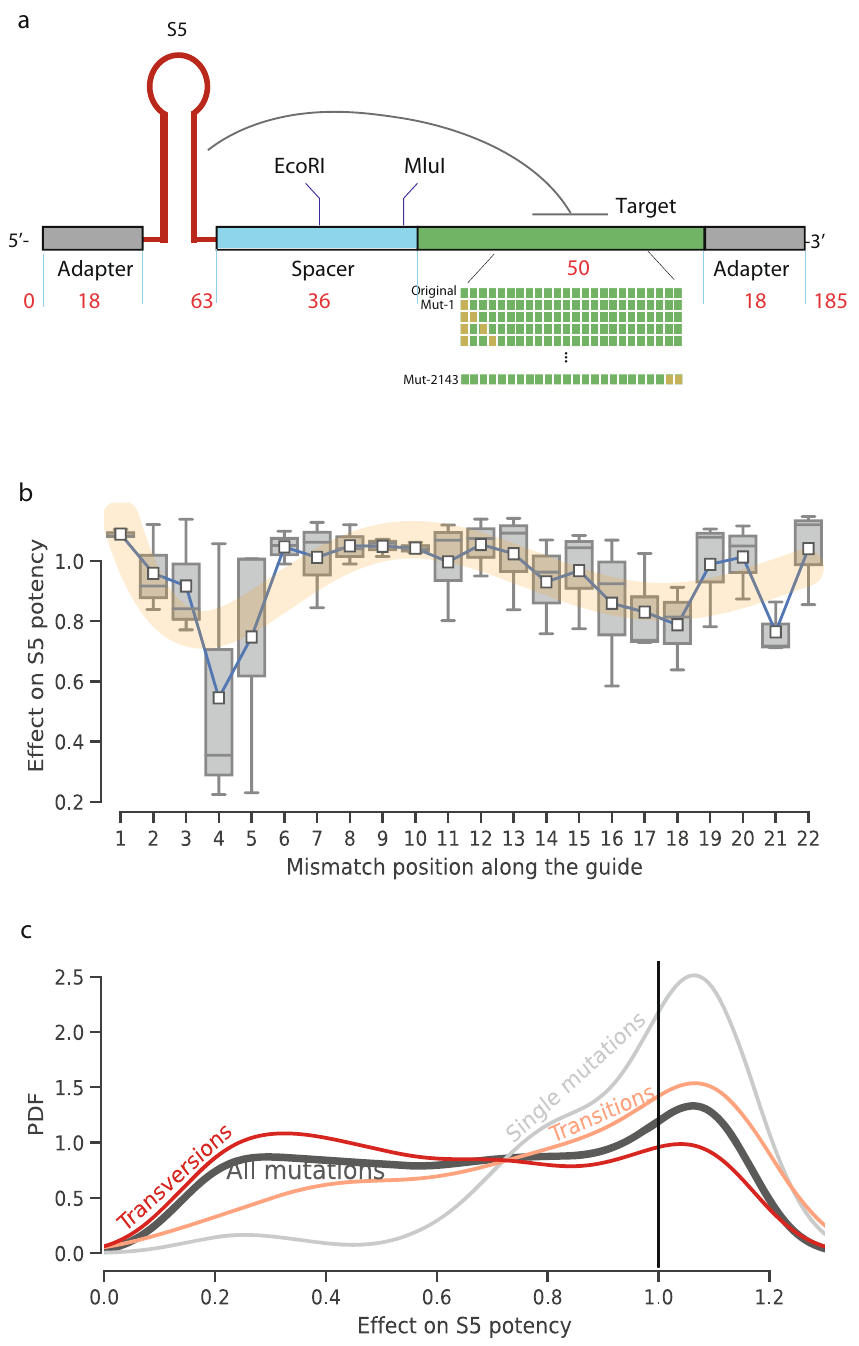
Fig. 4 Saturation mutagenesis. a The design scheme of oligos used in this setting. The library consisted of the S5 as the shRNA trigger with 2,143 mutations, exhaustively depicting every possible single- and double-mismatch in the siRNA target site; b The effect of mismatches strati fi ed by position for n = 66 shRNAs with a single mismatch. The X axis represents positions along the guide strand. Blue: mean values. Yellow: smoothed mean effect; Squares represent the mean, horizontal lines represent the median, box edges represent the 25% and 75% quartiles, and the whiskers represent the furthest data points within up to 50% of the interquartile range. c The distribution of the effect of mutations on the activity of S5. The vertical line at 1.0 (X axis) signi fi es scores that are identical to the screen score of a target site devoid of any mutation. Black: the distribution of effects of all 2143 single and double mutations. Grey: the distribution of all single mutations. Orange: the distribution of all double transitions. Red: the distribution of all double